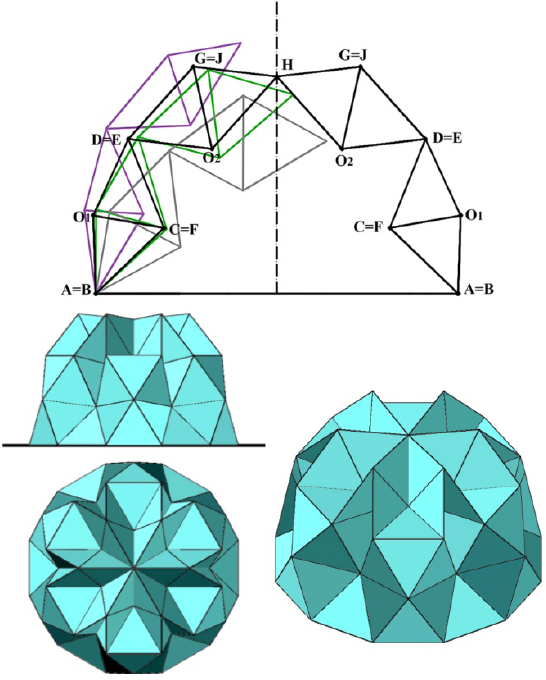
Figure 5. CP IV-12B(CQ * O 2 ) - vertical section of three posi– tions of a unit cell, orthogonal projections and spatial model